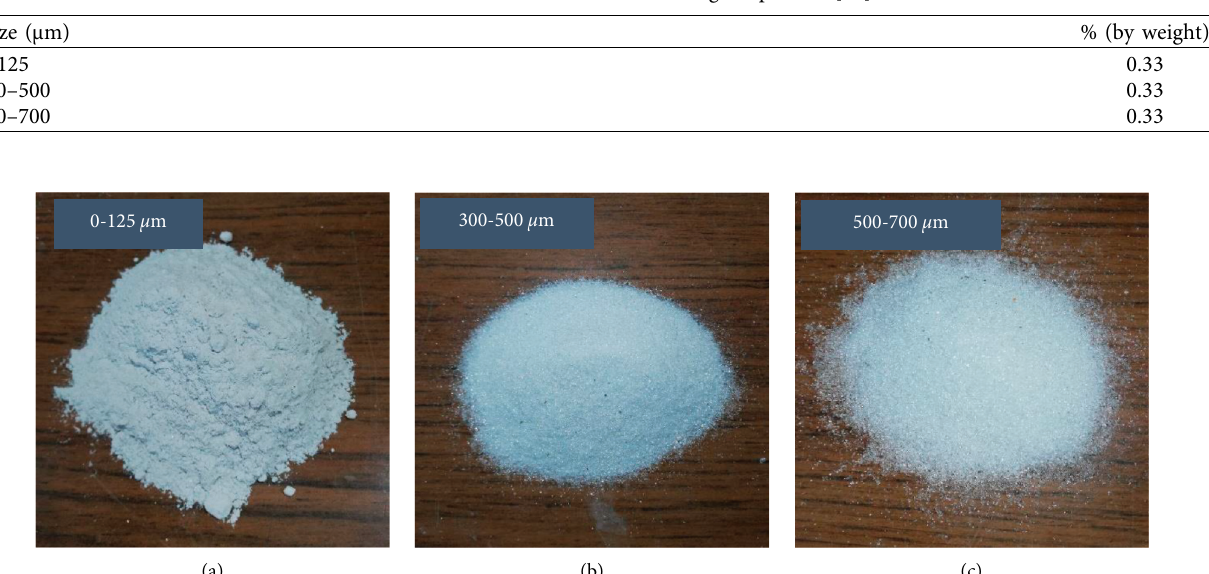
Table 5: Gradation and rate of used waste glass powder [43].